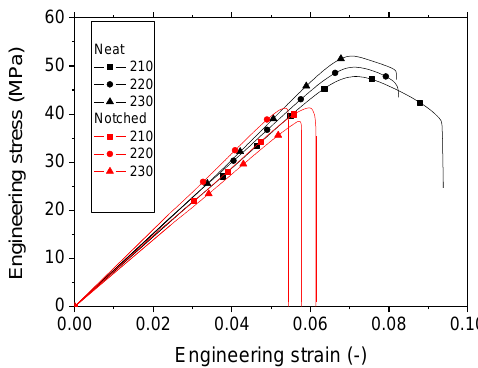
Figure 8. Tensile response of neat and notched 3D-printed PLA as a function of the printing temperature.